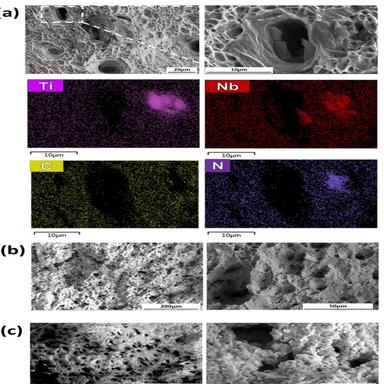
SEM characterization on fractured surface of tensile samples broken at 500 C with elemental mapping (a), 700 C (b), and 900 C (c), showing ductile fracture process with dimple-cavitation structure.